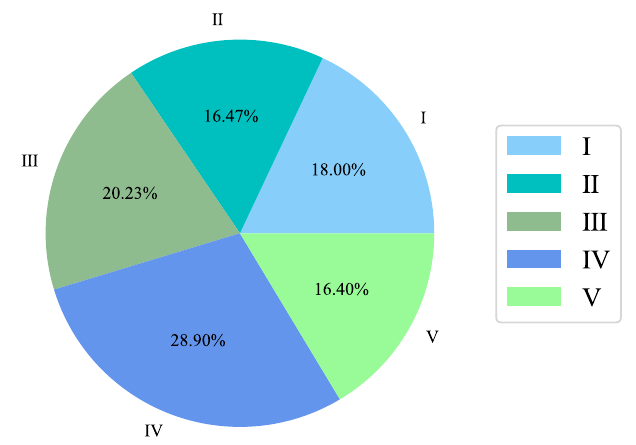
Figure 5. Water quality evaluation grade frequency distribution.